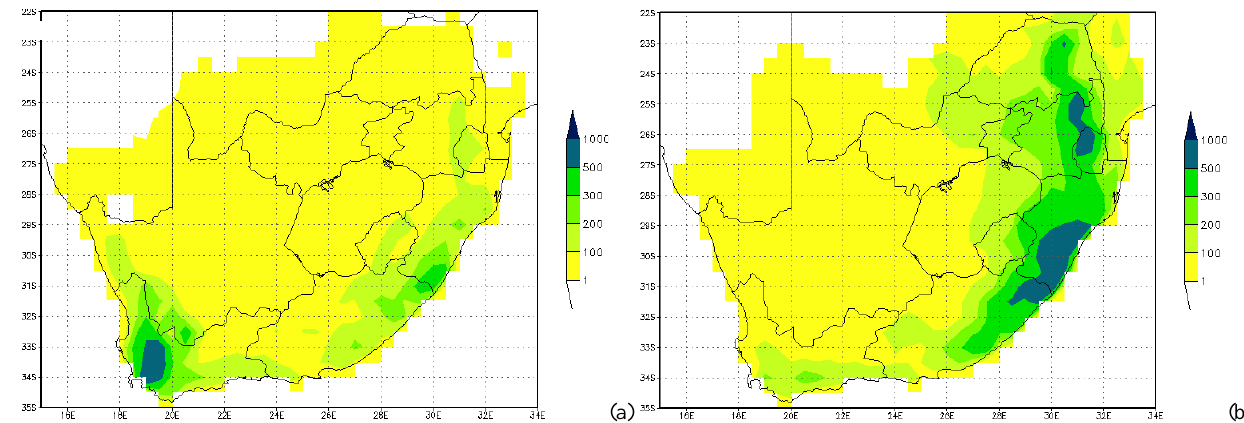
Fig. 8. Pseudo stratiform rainfall from gauges for winter months (a) and summer months (b) for 2008 and 2009.